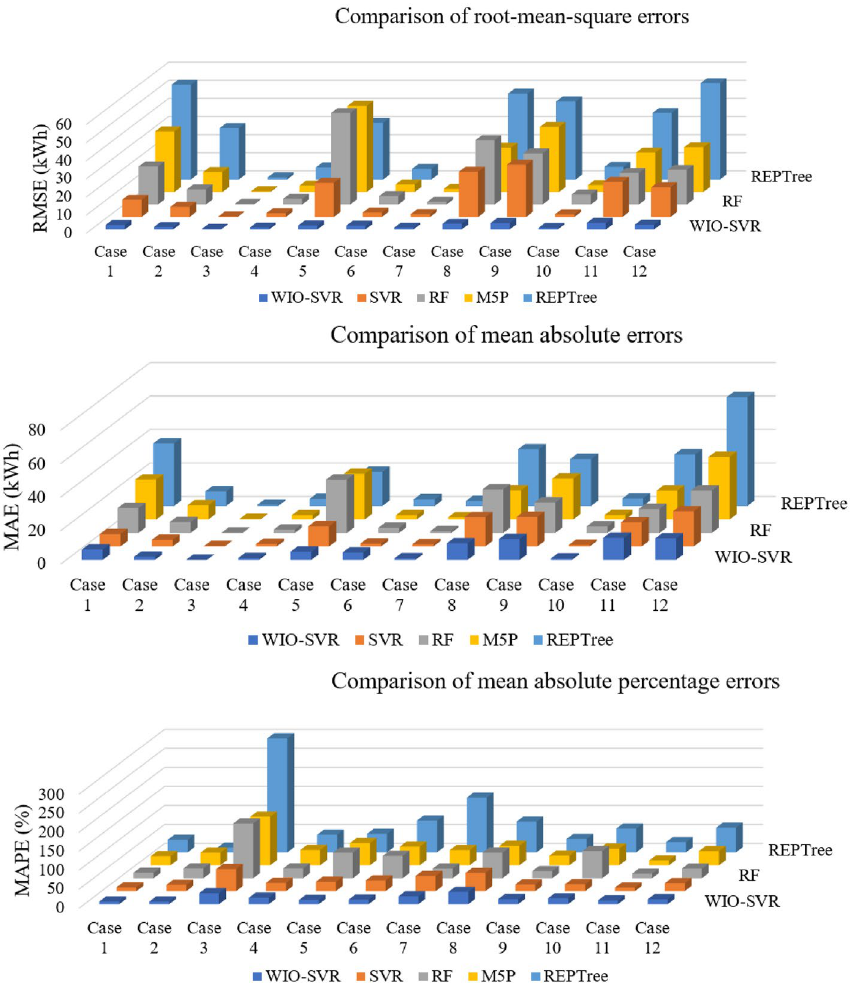
Figure 12. Performance comparison of all